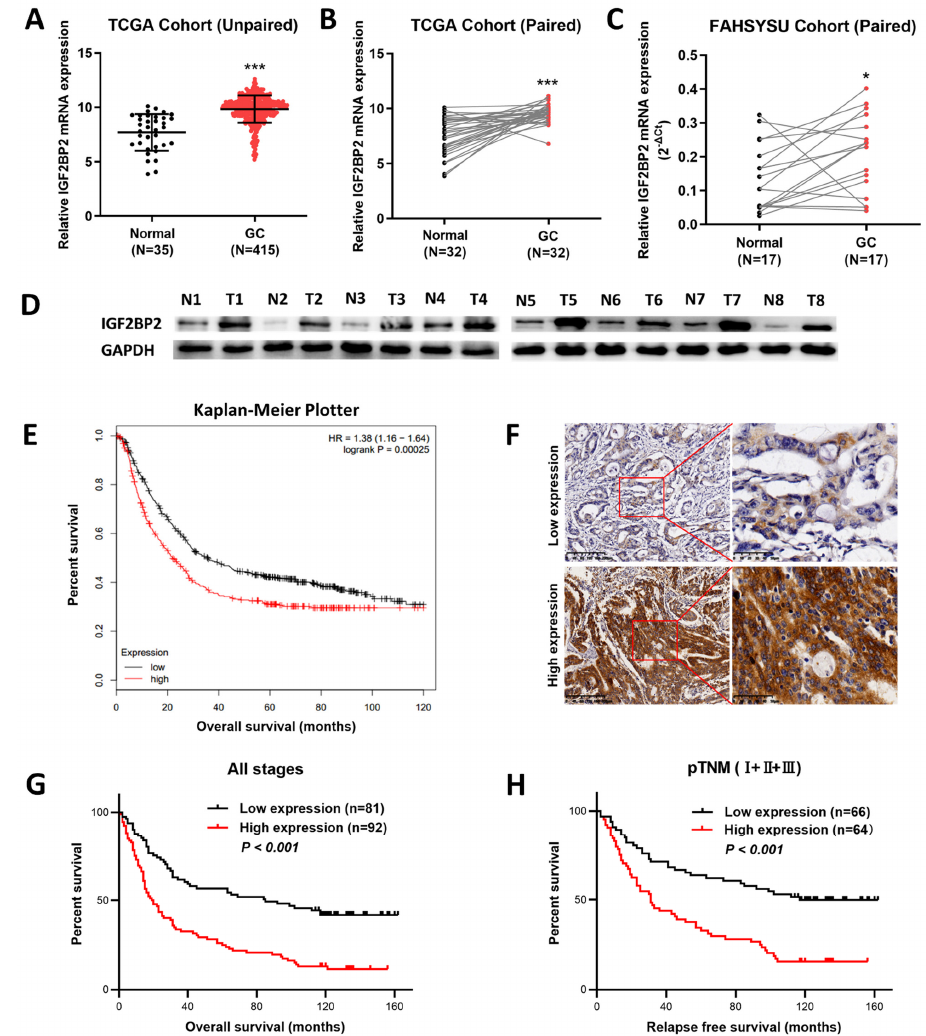
Figure 1. The expression of IGF2BP2 in GC tissues is remarkably upregulated, which predicts poor survival in GC patients. ( A , B ) The data from the TCGA database show the expression levels of IGF2BP2 in unpaired or paired GC and normal gastric tissues. ( C ) Expression levels of IGF2BP2 in paired GC and normal gastric tissues detected RT-PCR. ( D ) Representative results of the IGF2BP2 protein upregulation in GC specimens determined by Western blotting. ( E ) The correlation of high or low IGF2BP2 expression with the overall survival of GC patients according to the Kaplan– Meier plotter database. ( F ) Representative results of immunohistochemical staining of IGF2BP2 in GC specimens (200 × ). ( G , H ) The expression of IGF2BP2 upregulation was obviously related to poor overall survival and relapse-free survival in GC patients through Kaplan–Meier survival analysis. * p < 0.05, *** p < 0.001. Molecular weights for proteins are shown in the uncropped Western blot images (Figure